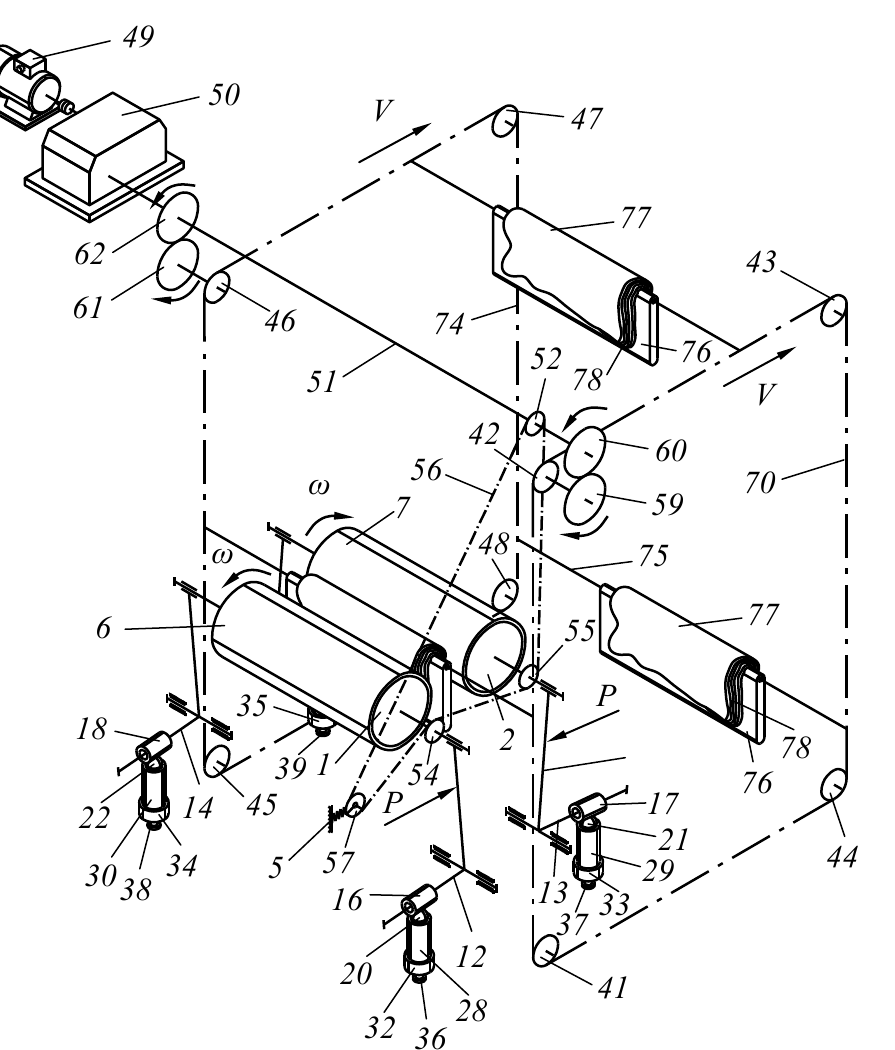
Figure 4. Scheme of the general view of the roller squeezing machine. Double-arm levers 12, 13, 14, and 15 are mounted on bearings 8, 9, 10, and 11 on the trunnions of squeezing shafts 1 and 2, and one arm is located at a right angle relative to the other arm. These double-arm levers at the junction are pivotally located on frame 5. Sliders 16, 17, 18, and 19 are installed on the small arms of levers 12, 13, 14, and 15 (see Figure 2). Supports 20, 21, 22, 23 resting on springs 24, 25, 26, 27, or on the rods of hydraulic cylinders are located under the sliders, and springs 24, 25, 26, and 27 are installed inside cylinders 28, 29, 30, 31. At the lower end of hydraulic cylinders 28, 29, 30, and 31, covers 32, 33, 34, and 35, are threaded. Bolts 36, 37, 38, and 39 are threaded in the center of covers 32, 33, 34, and 35 to tighten springs 24, 25, 26, and 27. Vertical feed on base plate 40 is realized through two parallel chain conveyors 70 and 74, installed in the zones of the trunnions of squeezing rolls 1 and 2 on toothed sprockets 41, 42, 43, 44 and 45, 46, 47, 48, respectively. The rotation of squeezing rolls 1 and 2 is realized via electric motor 49 through gearbox 50 and shaft 51. Sprocket 52 is installed on shaft 51, and sprockets 54 and 55 are installed on squeezing rolls 1 and 2, respectively (Figure 3). To tension chain 56, sprocket57 is installed on axle 58, placed on the fork with spring 59, and its other end is attached to frame 5. Gears 59 and 60 are installed on shaft 51 at both ends of squeezing rolls 1 and 2. Gears 59 and 60 are in contact with gears 61 and 62, respectively. Gears 61 and 62 are placed on axles 63 and 64, and sprockets 65 and 66 are installed at the other end. Chain 70 is mounted on sprockets 65, 67, 68, and 69. Chain 74